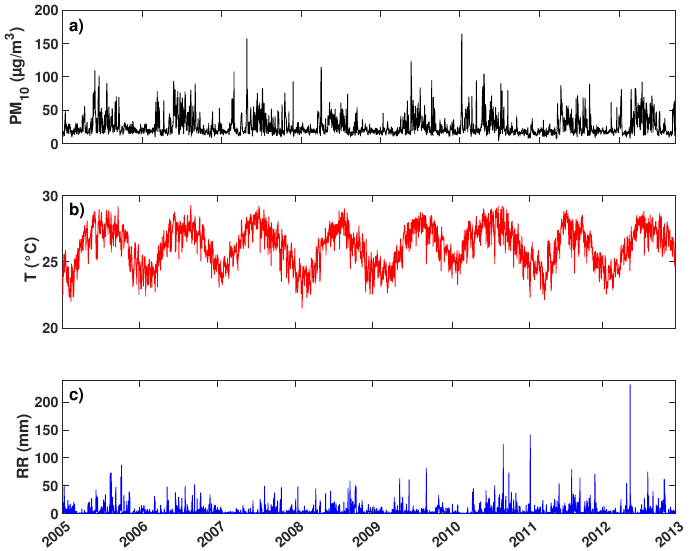
Figure 1. Synchronous measurements of ( a ) PM 10 concentrations, ( b ) air temperature ( T ), and ( c ) rainfall ( RR ) from 2005 to